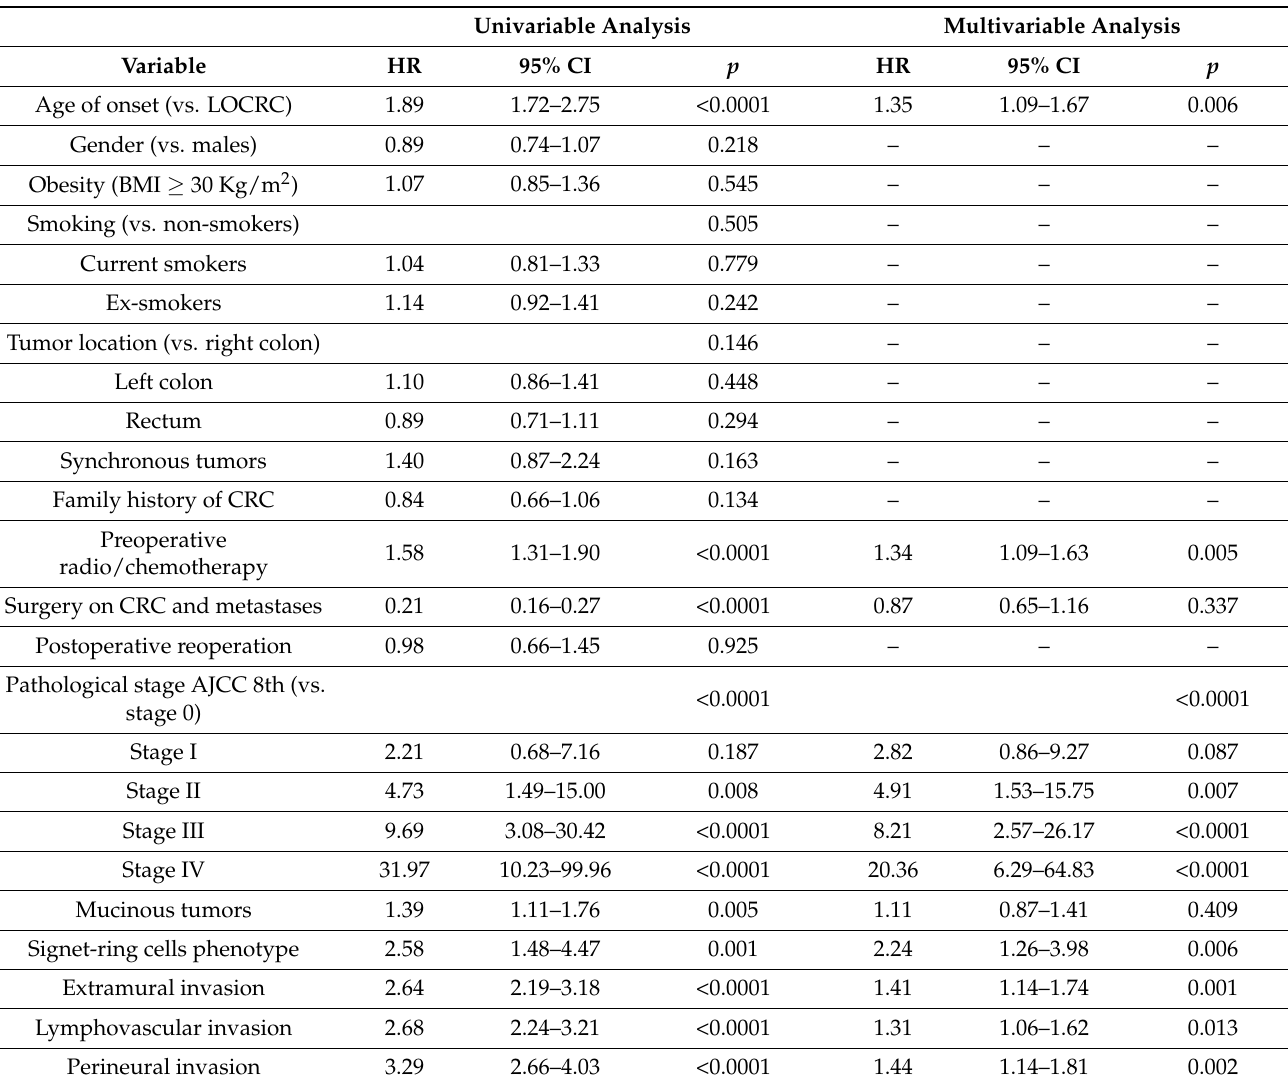
Table 5. Cox proportional hazard regression analysis on